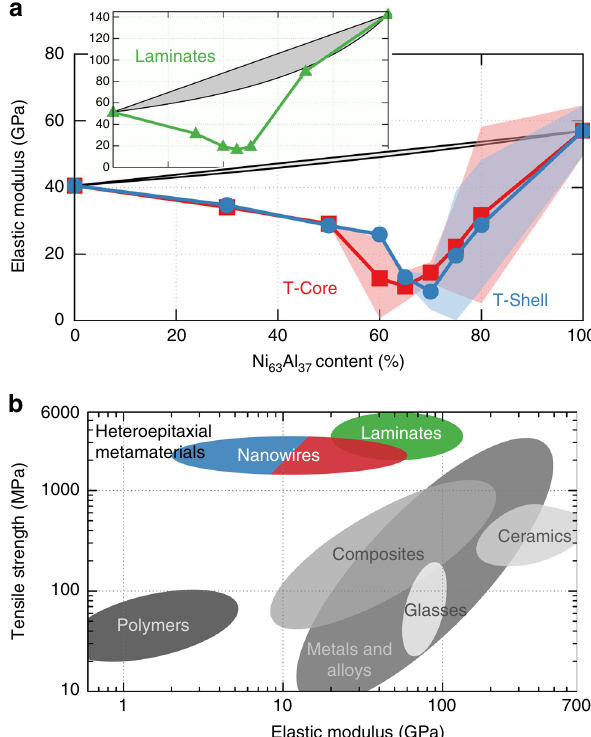
Fig. 5 Ultra-low stiffness for nanoscale heteroepitaxial metamaterials. a Stiffness of metamaterial nanowires as a function of Ni 63 Al 37 composite fraction for T-Core and T-Shell con fi gurations. Black lines (and gray shading) show standard rule of mixtures. Shaded region shows ± 2 standard deviations from cyclic loading of multiple independent samples with randomized compositions (see “ Methods ” section, Supplementary Note 2, and Supplementary Fig. 6). Inset shows stiffness of nanolaminate structures with identical x axis (Supplementary Note 4). b Ashby plot